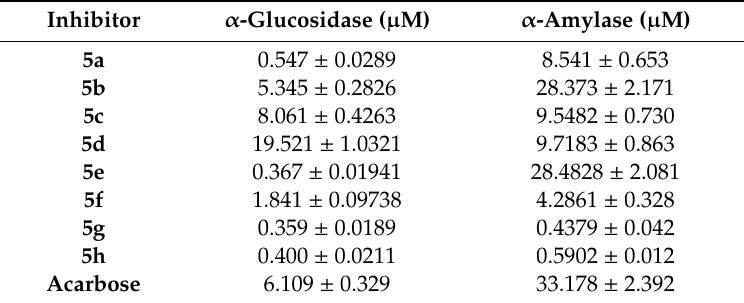
Table 1. α -Glucosidase and α -amylase inhibitory activities of compounds 5a – h